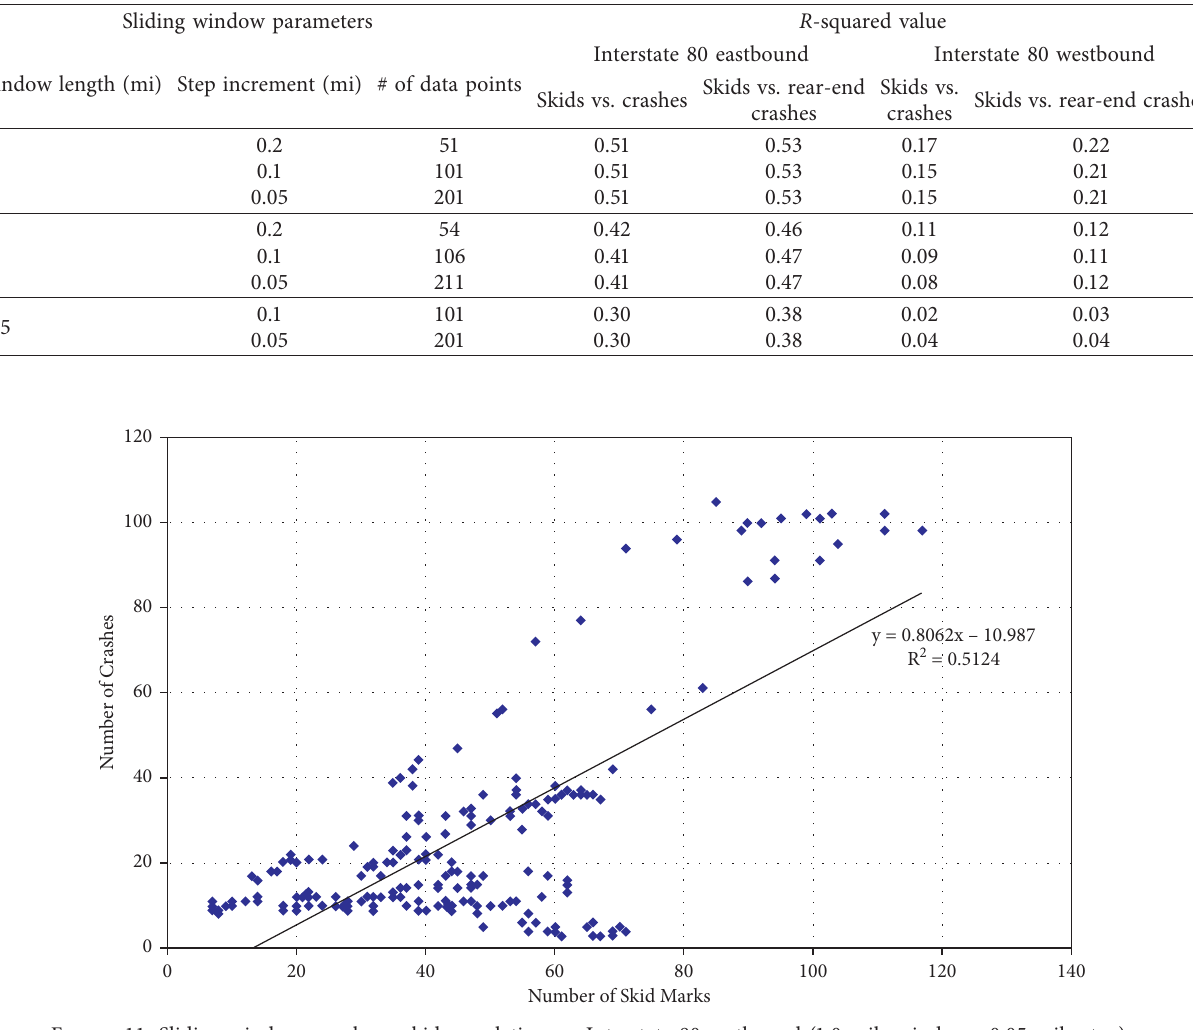
Figure 11: Sliding windows crash vs. skid correlation on Interstate 80 eastbound (1.0-mile windows, 0.05-mile